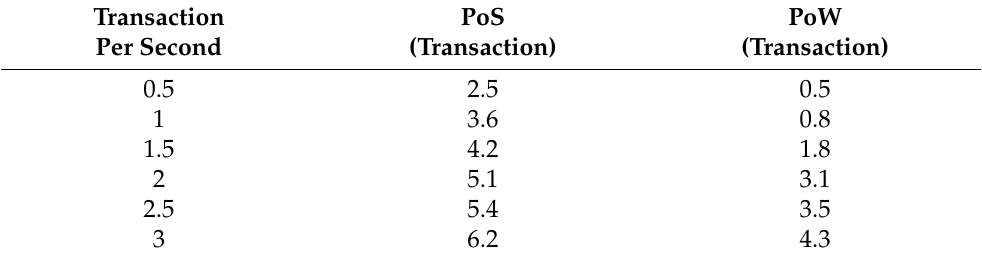
Table 2. Comparison of Transactions per second, PoW vs. PoS.